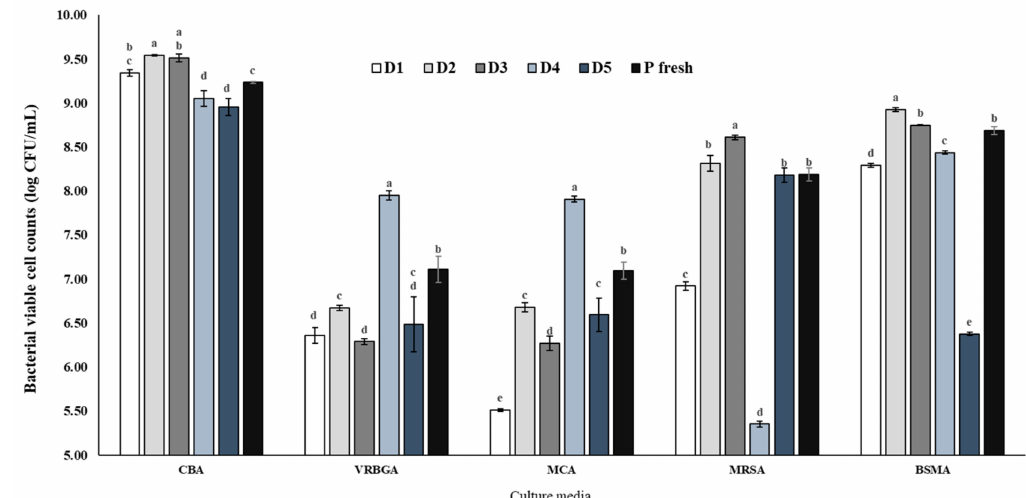
Figure 3. Bacterial viable cell counts (log CFU/mL, mean ± SD) of fresh individual (D1–D5) and pooled inoculum (P Fresh) from human donors obtained using different culture media incubated for 72 h at 37 ◦ C in anaerobic conditions. Different letters mark statically significant ( p < 0.05) differences between conditions plated at each culture